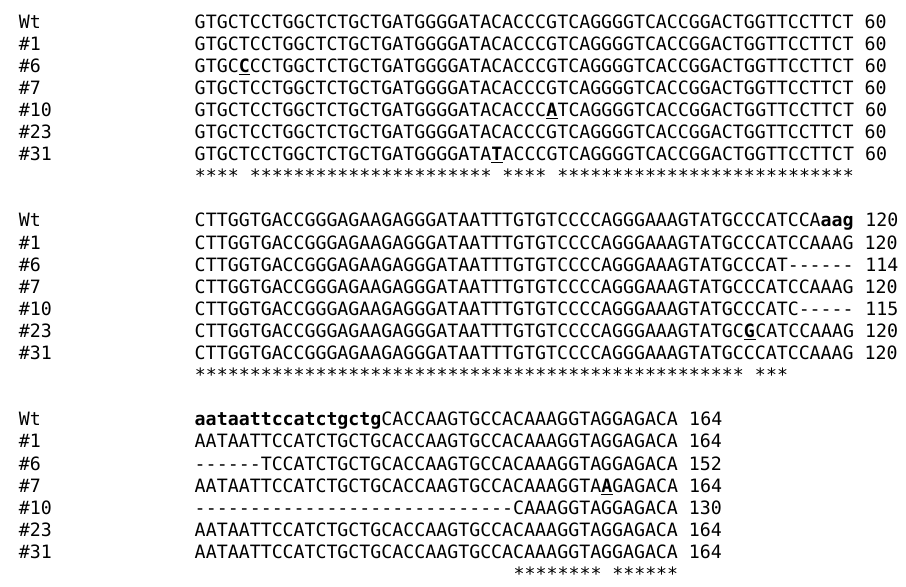
Figure 2: Cas9 induced mutations in rat Tnfrsf1a exon 2. Five out of thirty one F0 rats showed mutations in exon 2 near the designed target after microinjection of Cas9 against Tnfrsf1a . In this CLUSTALW2 alignment, “wt” was the theoretical wild type genomic sequence with Cas9 target in lower-cased letters. #6, #7, #10, #23 and #31 showed point mutations marked with underlines. #10 and #23 also had deletions as indicated by “-”. Identical positions were marked by “*”. The sequences of other rats showed no change from the wild type, taking #1 for instance. Detailed sequencing files are included in additional file 2.